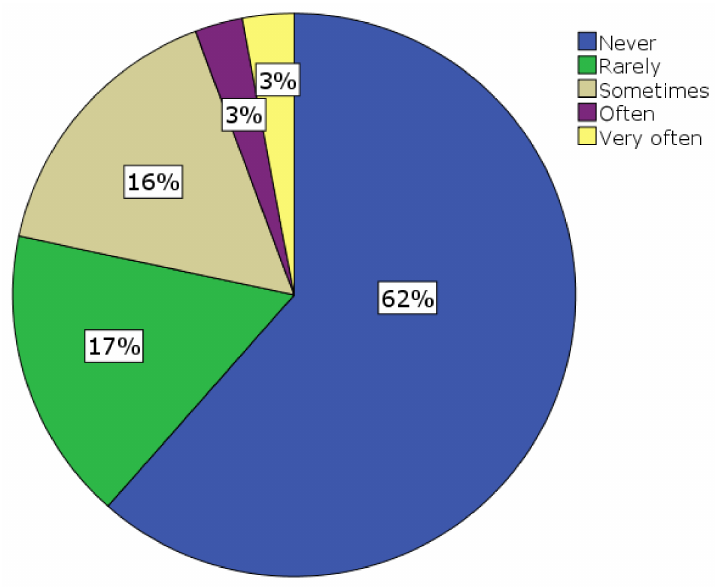
Figure 7. How often does having no one to walk with prevent you from walking in